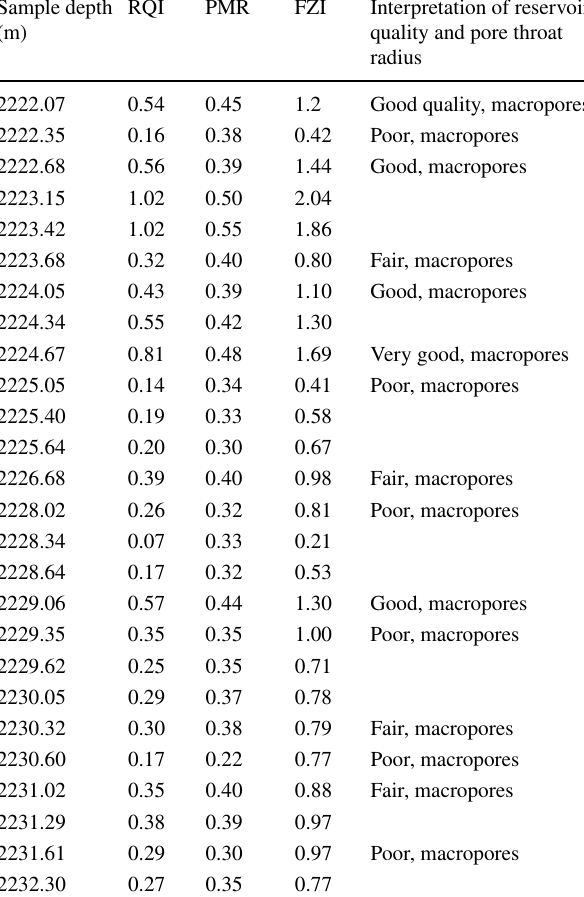
Table 4 Reservoir quality index (RQI), flow zone indicator (FZI) and pore matrix ratio (PMR) of PZ-2 well, Niger Delta Sample depth (m)